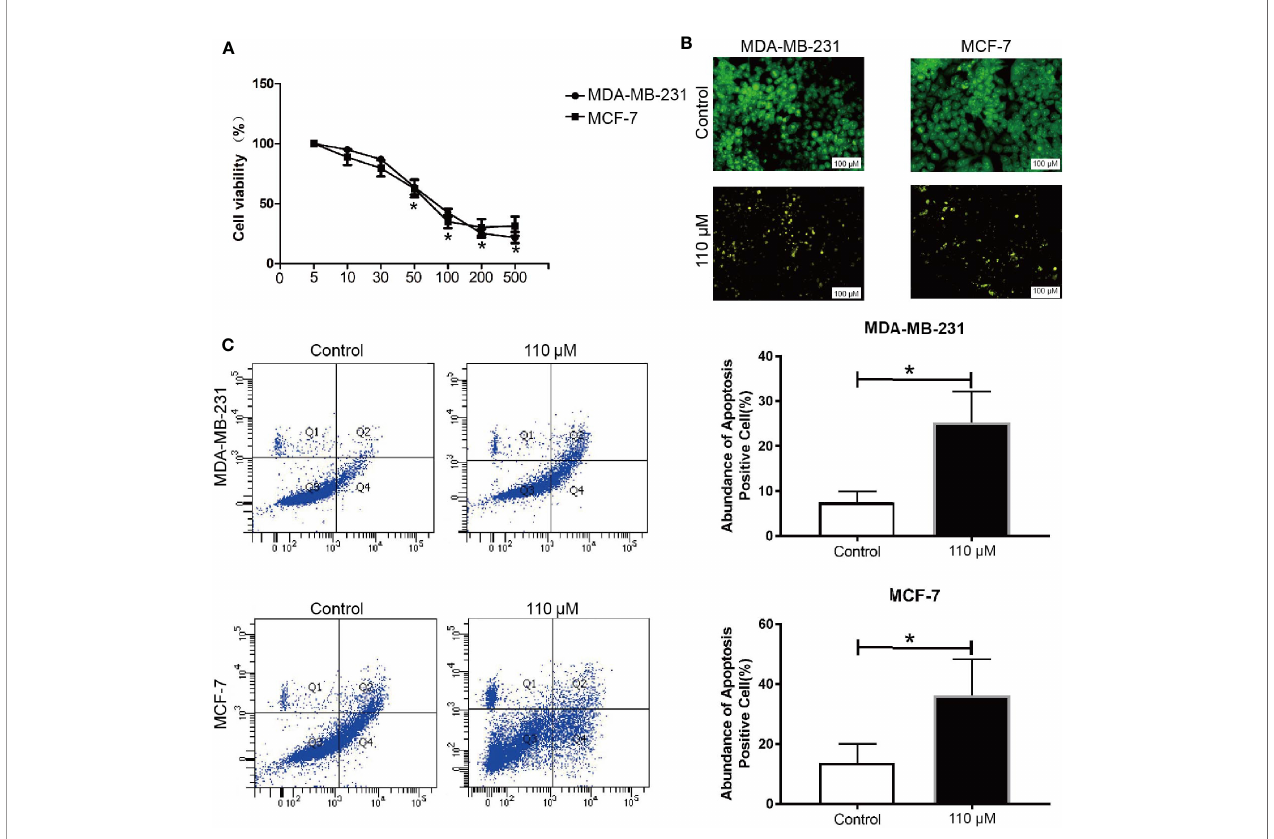
FIGURE 1 | Emodin inhibit BC growth in vitro . BC cells were treated with Emodin for 48 h, (A) CCK-8 assay showed that Emodin inhibits BC cell growth in a dose- dependent manner. (B, C) AO/EB staining and Flow cytometry were used to detect the apoptosis in BC cells. T test. * P < 0.05 vs Control